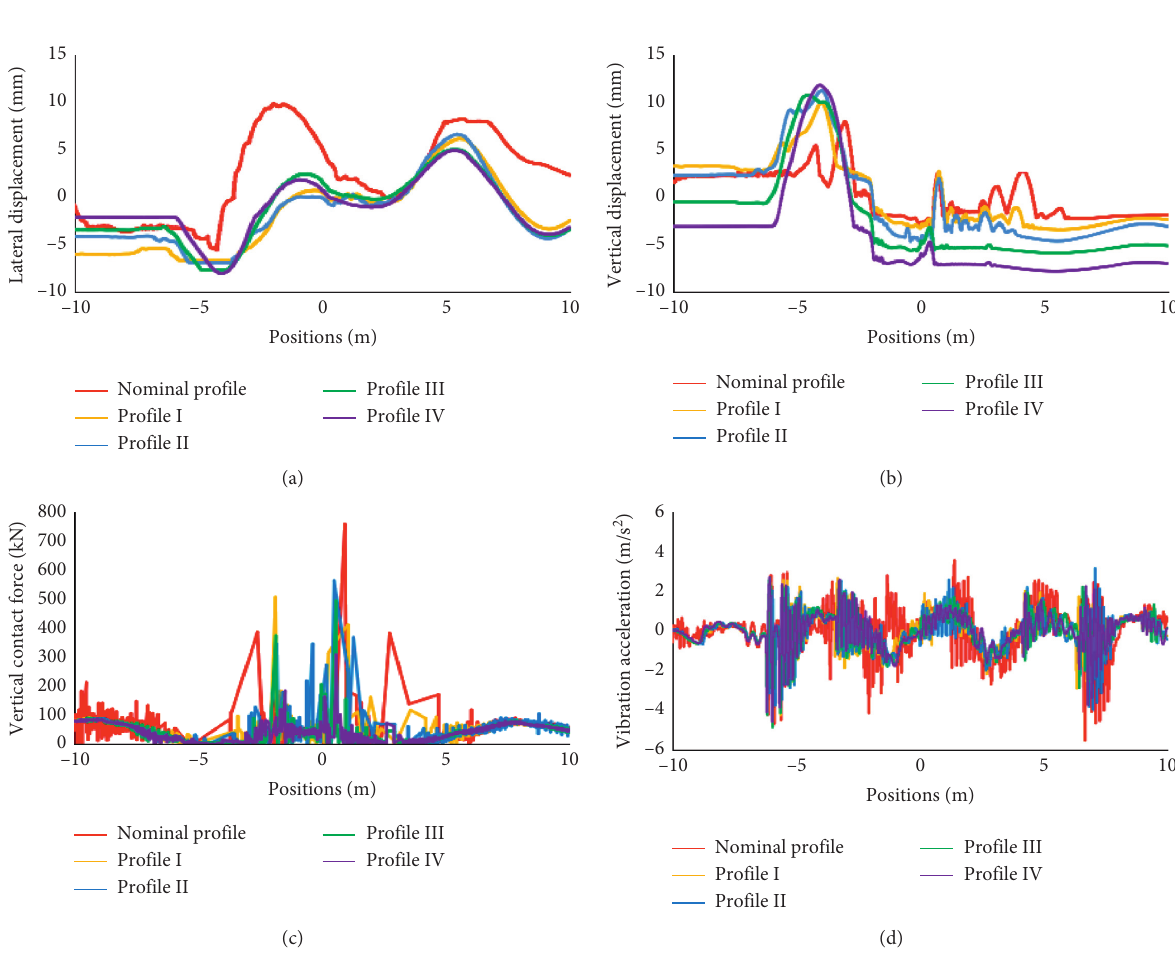
Figure 7: The comparison of the dynamic interaction of vehicle and fixed frog. (a) Lateral displacement of wheelset. (b) Vertical dis- placement of wheelset. (c) Vertical contact force. (d) Vibration acceleration of